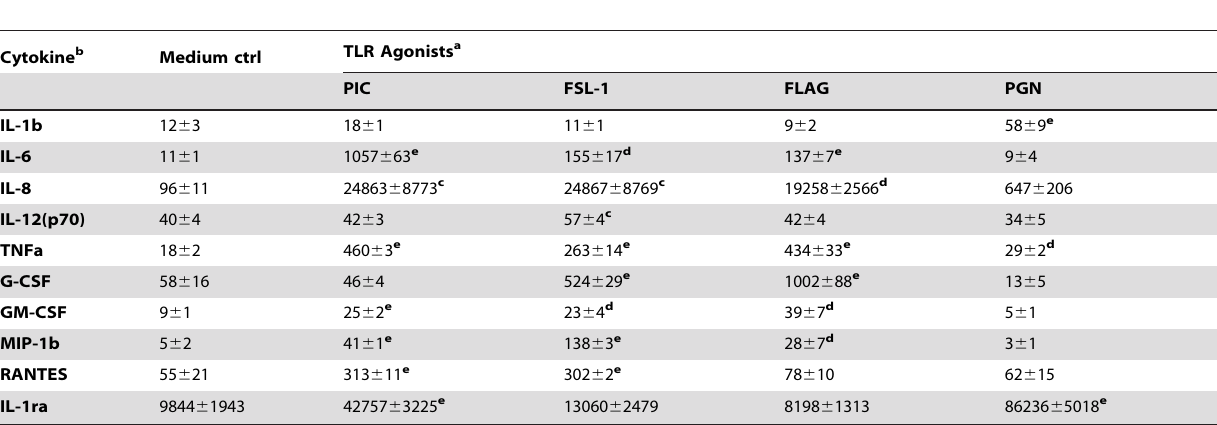
Table 1. TLR agonists induced specific cytokine profiles in VEC multilayer cultures.